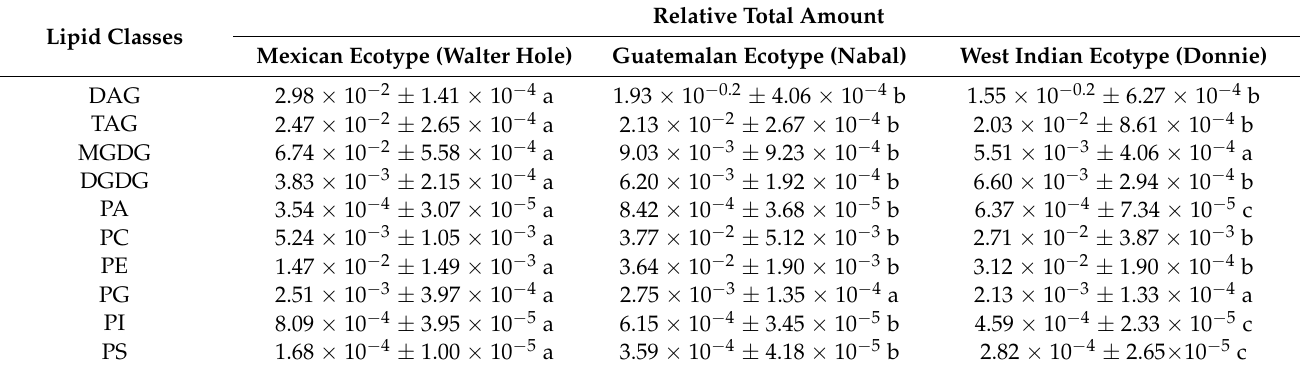
Table 1. Relative contents of ten classes comprising 857 lipids detected in the mature avocado mesocarps of three ecotypes. Relative Total Amount Lipid Classes Mexican Ecotype (Walter Hole)